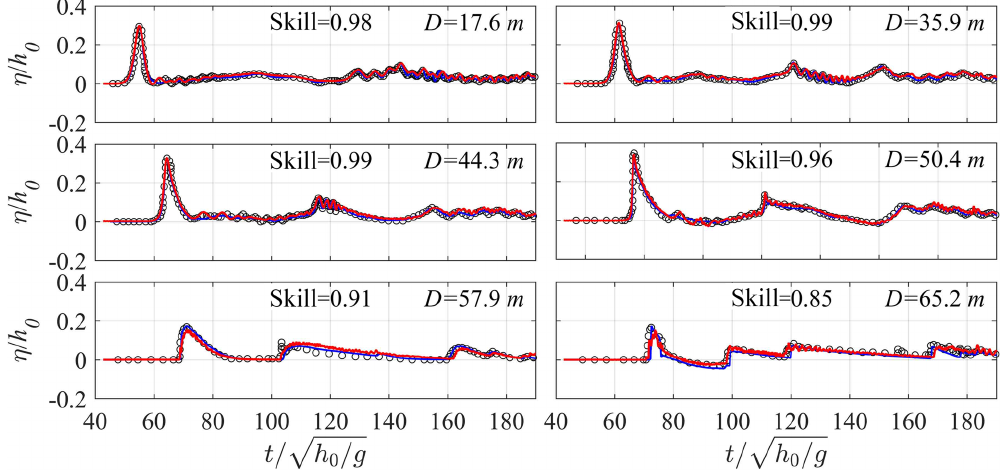
Figure 8. Time series of dimensionless free-surface elevations ( η/h 0 ) at different cross-shore distances from the wavemaker ( D ) for Sce- nario 2. Red lines – present simulations; blue lines – simulations from Roeber (2010); open circles – measurements from Roeber (2010); skill values are for the present simulations.